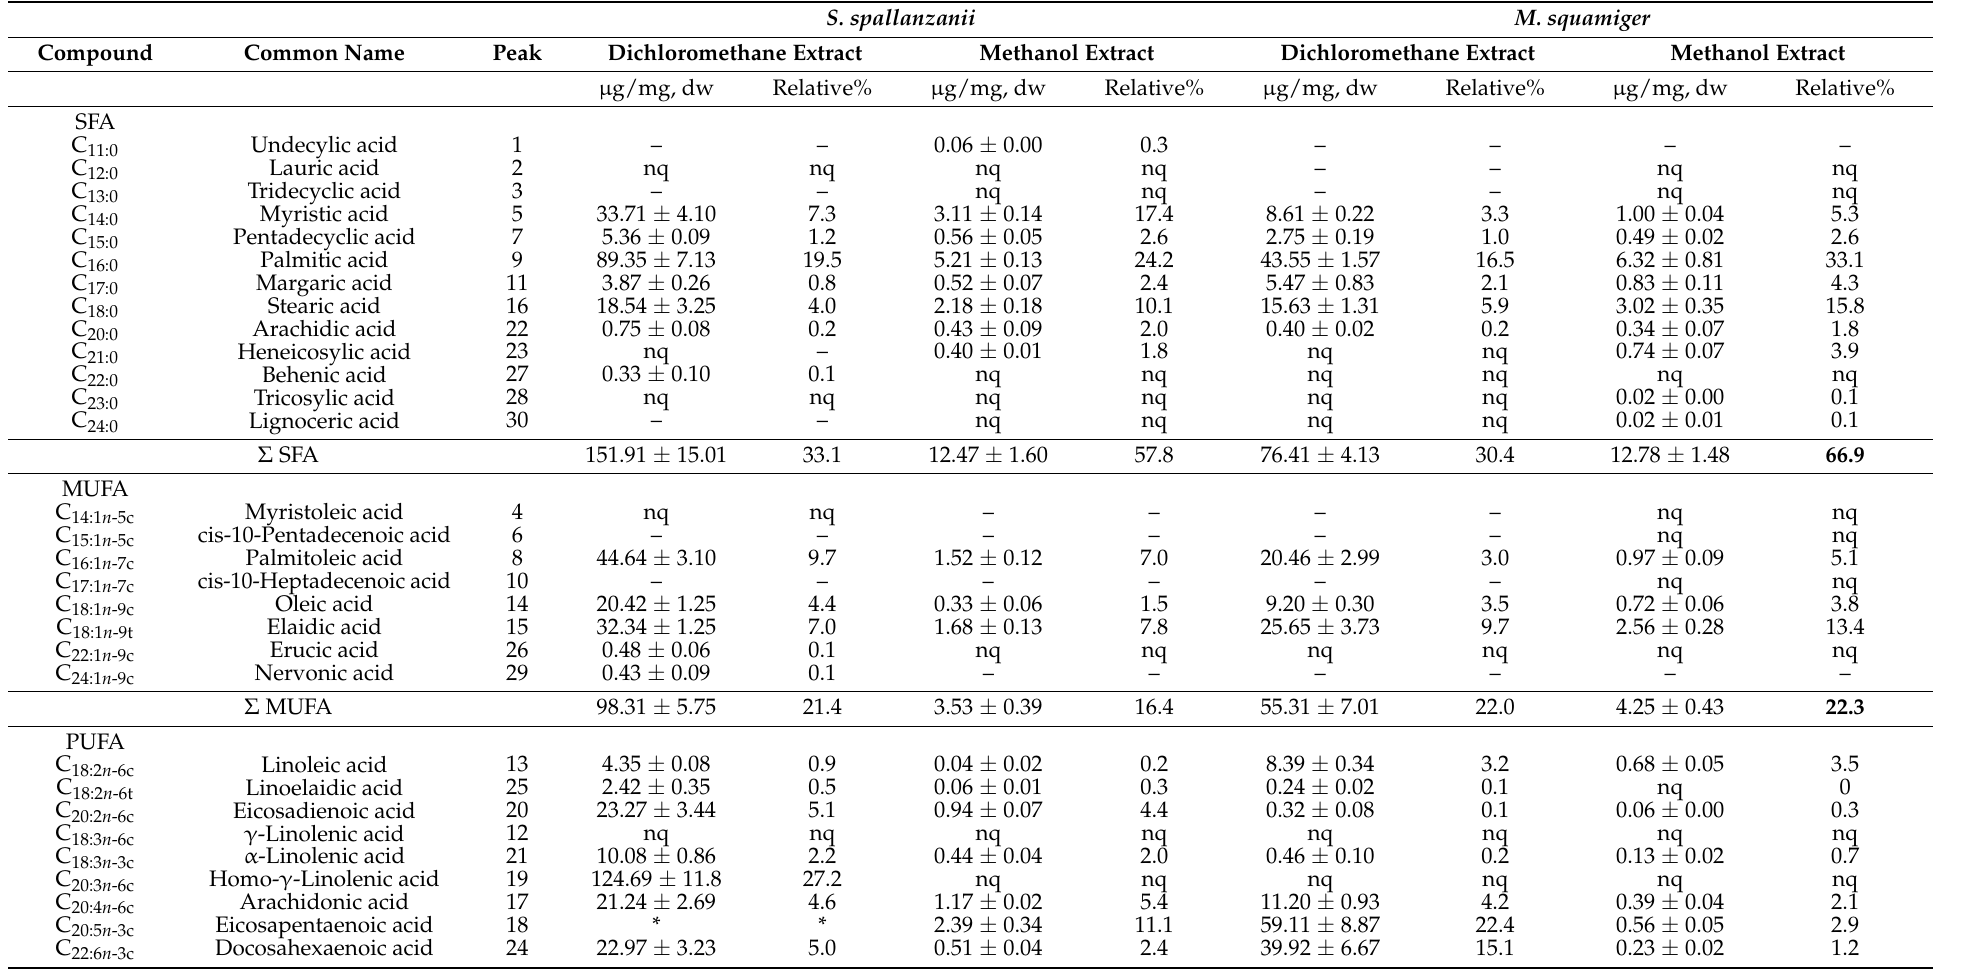
Table 4. Fatty acid content of Sabella spallanzanii and Microcosmus squamiger extracts ( µ g/mg dry extract, dw) 1